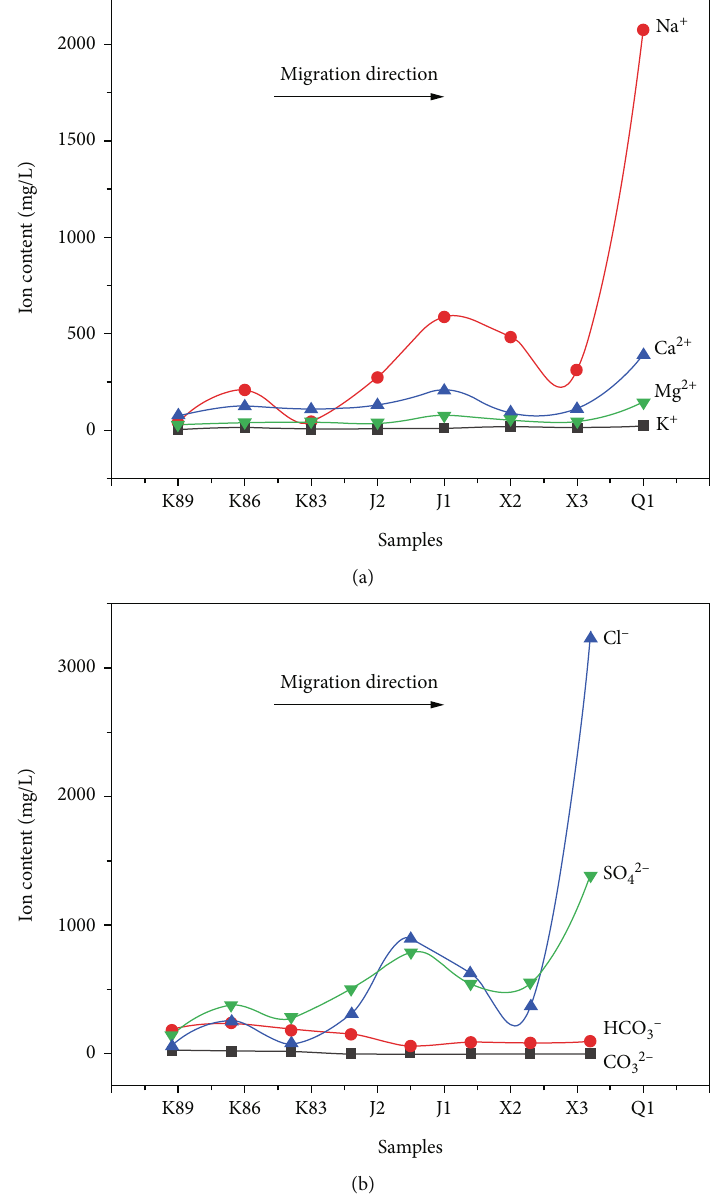
Figure 2: Changes in anions and cations concentrations with the transport process of water ((a) cations and (b)